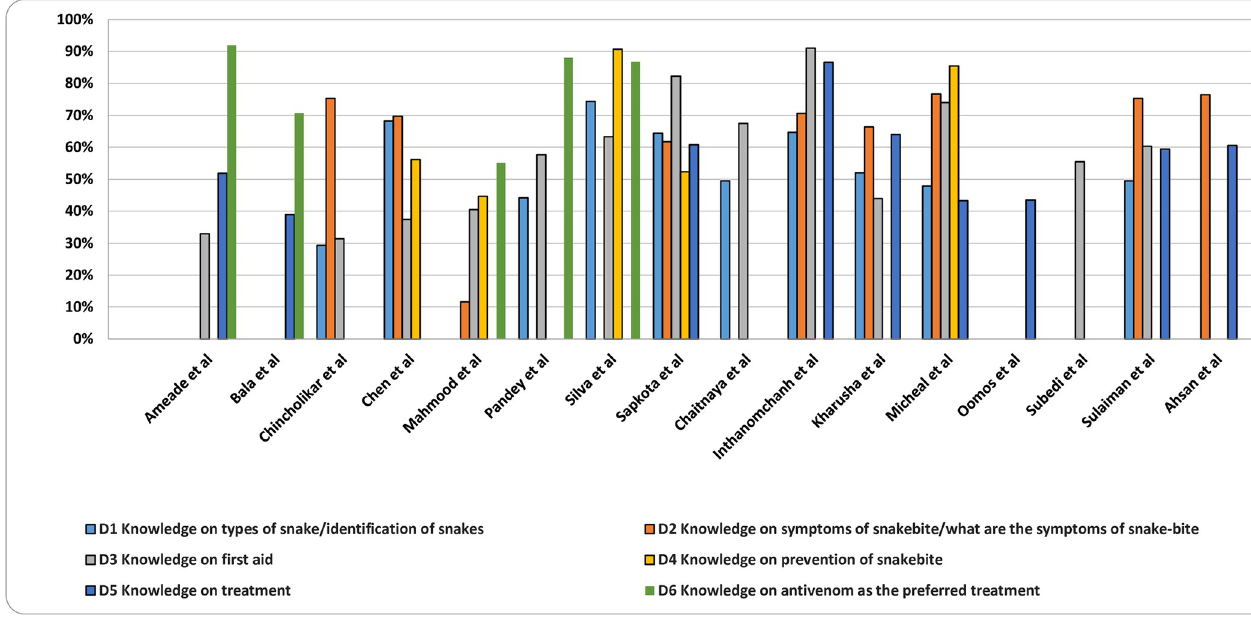
Fig 5. Knowledge scores on snakebite of selected domains [2,4,14,16,18,19,28,35–43].